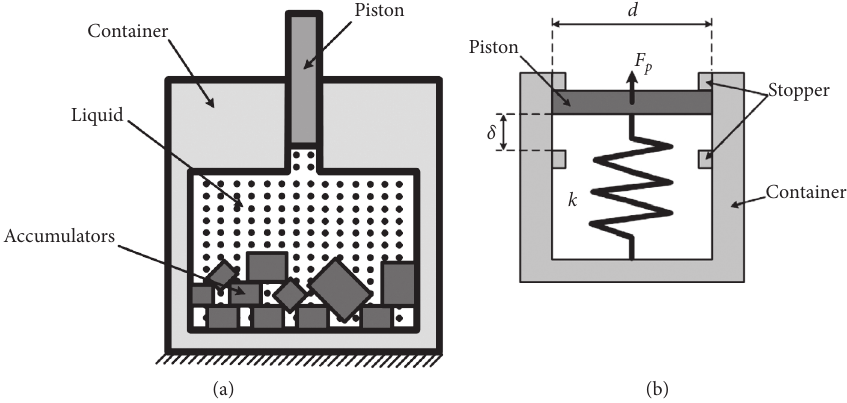
Figure 1: Experimental apparatus. (a) Schematic diagram of MMSI. (b) Hydraulic spring